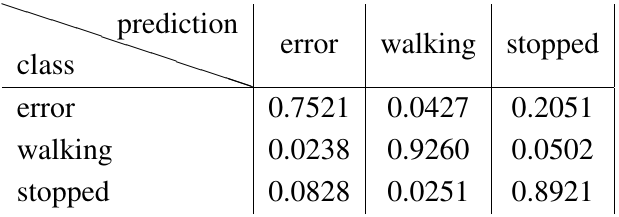
Table 6. Relative Confusion matrix for the HMM generated using GA to classify the activi- ties walking , stopped and